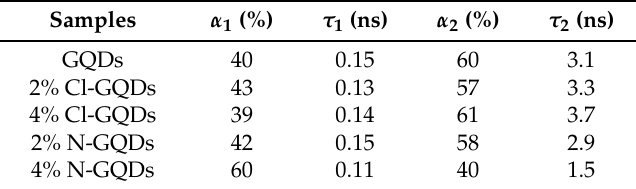
Table 1. The short and long lifetime components of N- and Cl-doped GQDs samples.